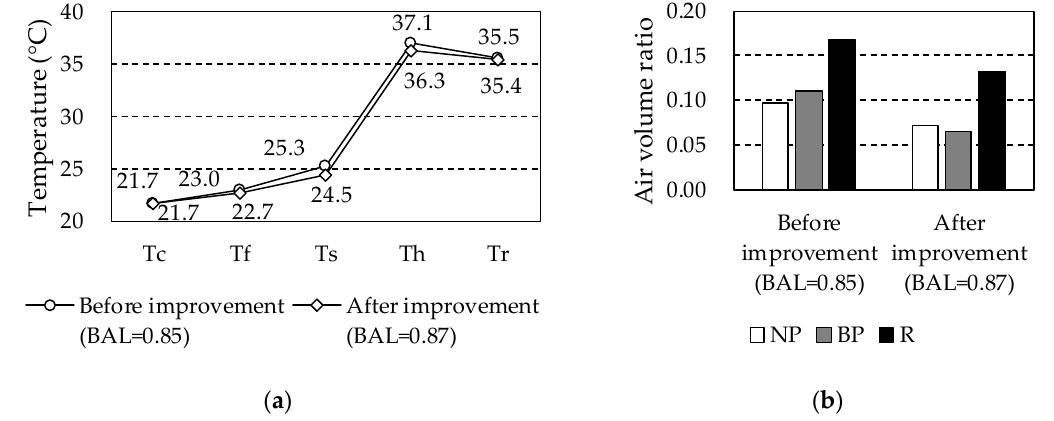
Figure 8. Improvement effect of thermal environment at CRAC fan frequency of 45 Hz: ( a ) average temperature of each part and ( b ) air-management metrics.